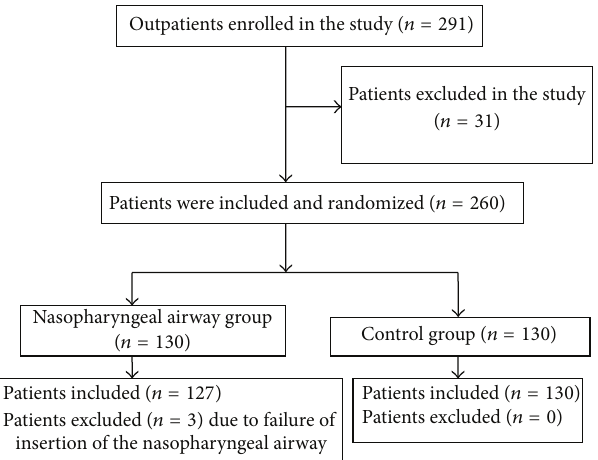
Figure 1: Flow chart showing the inclusion and exclusion criteria for the obese patients in the